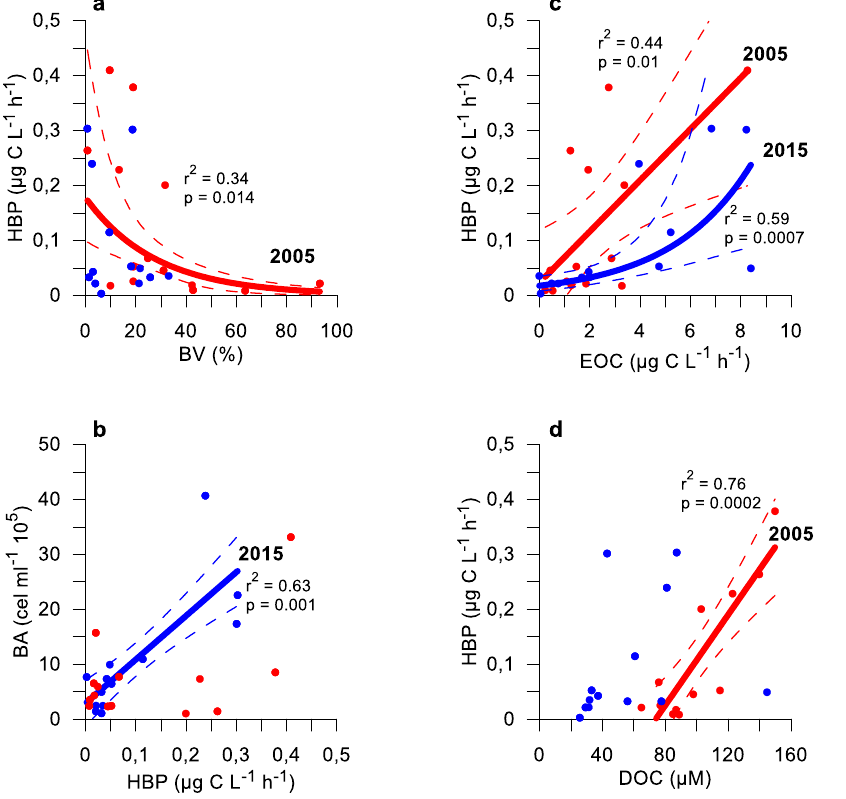
Figure 5. Relationship between Bacterial Production (HBP) and % bacterivory (%BV) ( a ), bacterial abundance (BA) ( b ), Excreted Organic Carbon (EOC) ( c ), and Dissolved Organic Carbon (DOC) ( d ). Data for 2005 and 2015 are represented in red and blue, respectively. Regression line, correlation coefficient (r 2 ) and p value are represented only for years with a significant relationship.